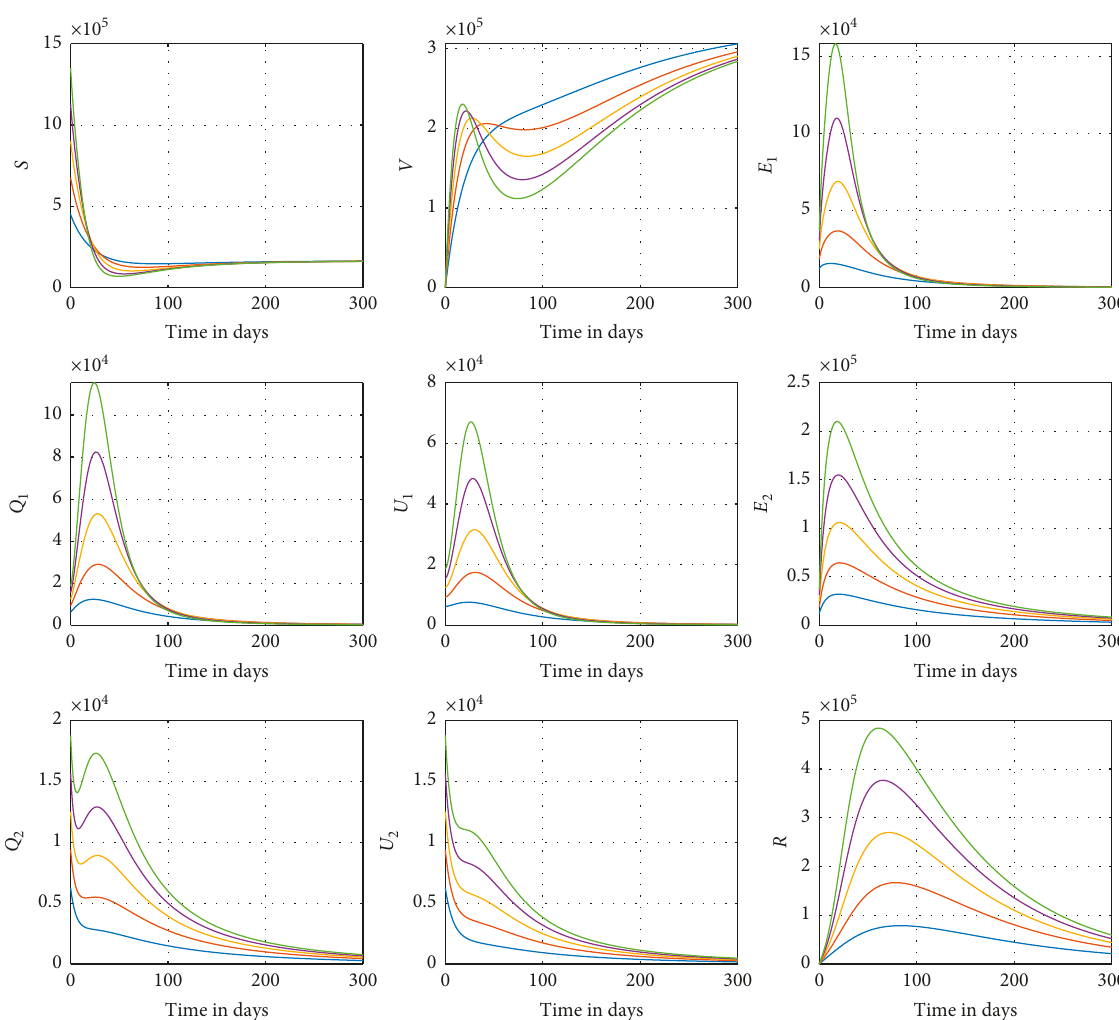
Figure 3: These graphs are obtained by numerically solving the proposed model using ψ � 0 . 7and ψ � 0 . 65 and other parameter values as 1 2 contained in Table 1. With this choice of parameter values, R c � 0 . 6742, where S is the susceptible individuals, V is the vaccinated in- dividuals, E is the individuals exposed to variant 1, Q is the quarantined individuals who are infected with variant 1, U is the undetected 1 1 1 is the individuals exposed to variant 2, Q is the quarantined individuals who are infected with individuals who are infected with variant 1, E 2 2 variant 2, U is the undetected individuals who are infected with variant 2, and R is the recovered 1